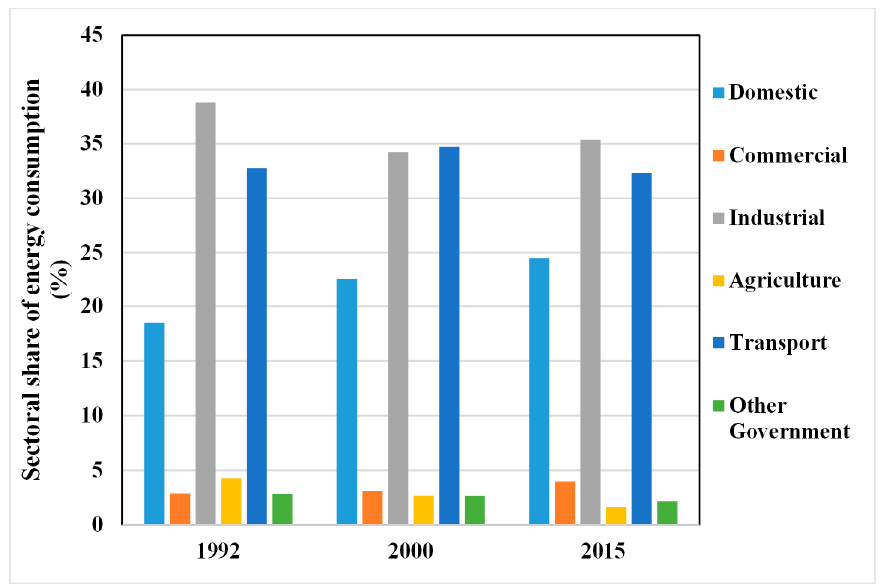
Figure 2. Historical share of energy consumption in different sectors [11–15].